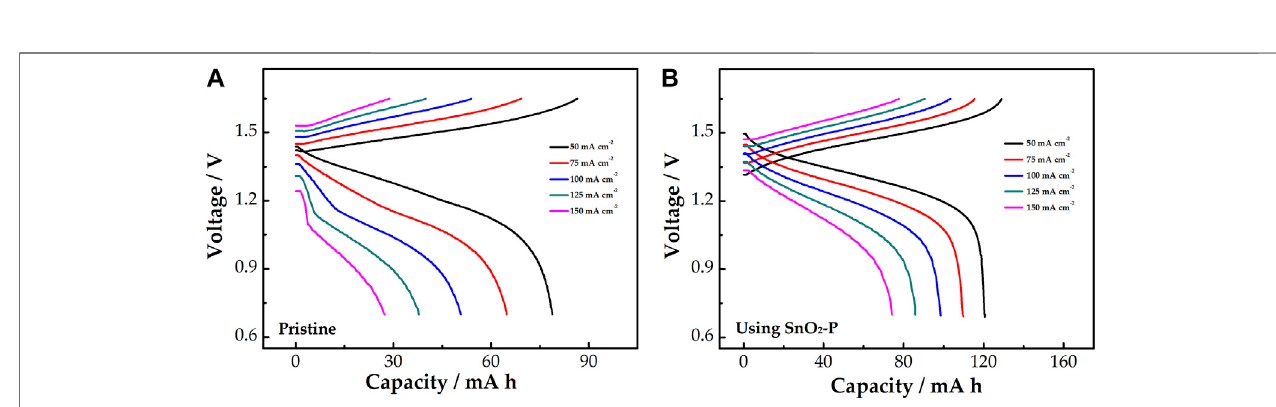
FIGURE 8 | Charge – discharge curves of pristine (A) and SnO 2 -P modi fi ed (B) cells at a current density of 50 – 150 mA cm − 2 .